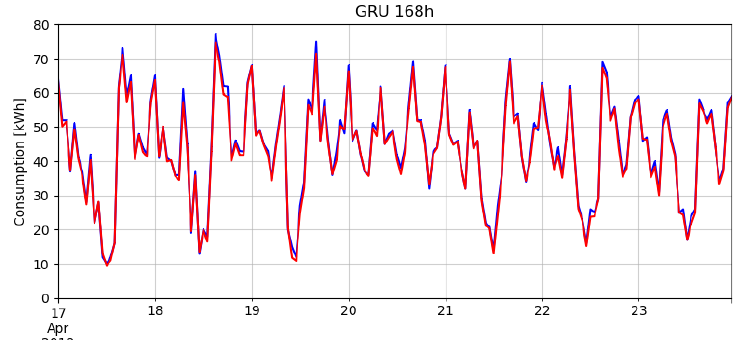
Figure 8. Predictions for one week in April 2019 by GRU with a horizon of 168 h (red line is for predicted values, blue line is for measured values).